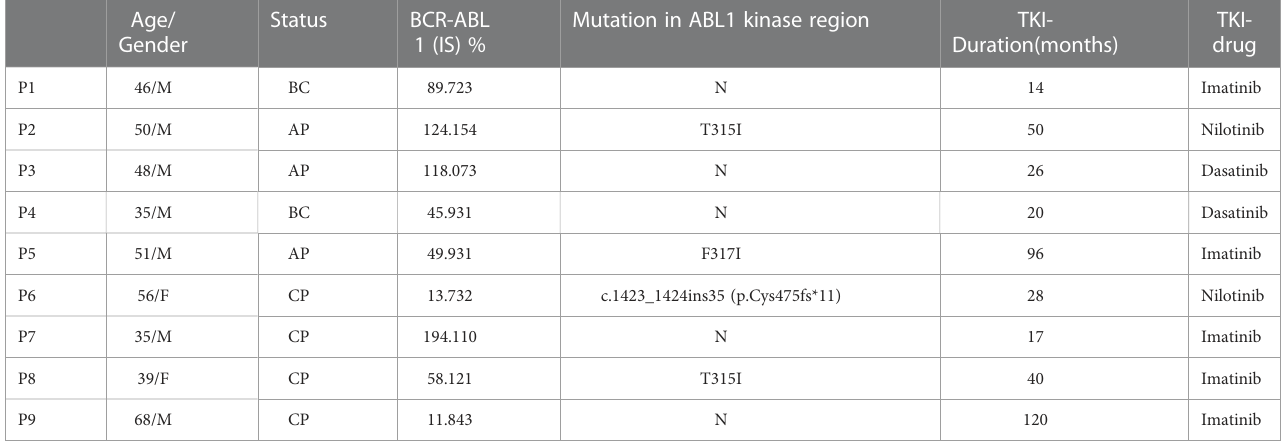
TABLE 3 TKI-F PB sample